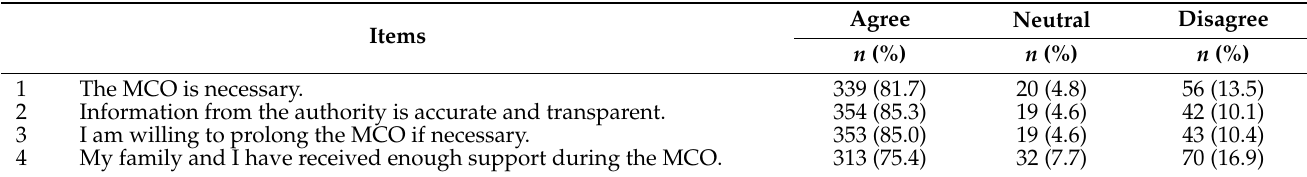
Table 3. General perceptions on the Movement Control Order (MCO) during the COVID-19